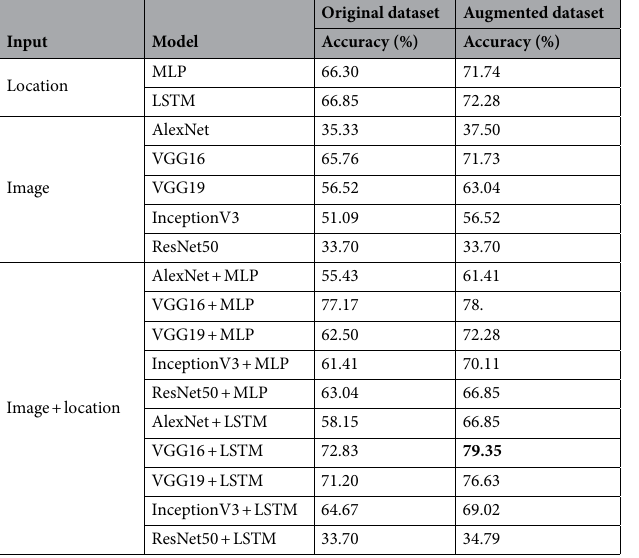
Table 3. Four wound class classification (D vs. P vs. S vs. V) on AZH dataset with original body map. The bold represents the highest results/accuracy achieved for each experiment.